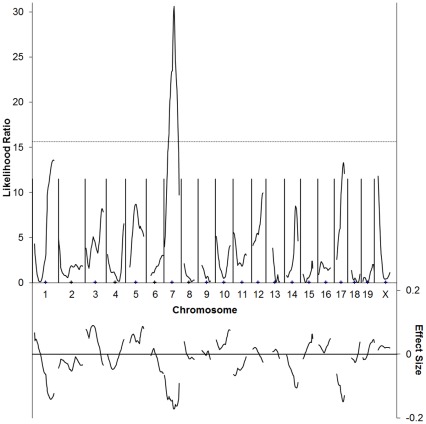
C57BL/6J×SJL/J F2 cross simple interval mapping.Whole genome simple interval map. Top: likelihood ratio statistic or likelihood of a region being linked to bFGF-induced corneal neovascularization. Dashed line indicates P = 0.05 as determined by bootstrapping. Bottom: predicted additive effect of a region on bFGF-induced corneal neovascularization.